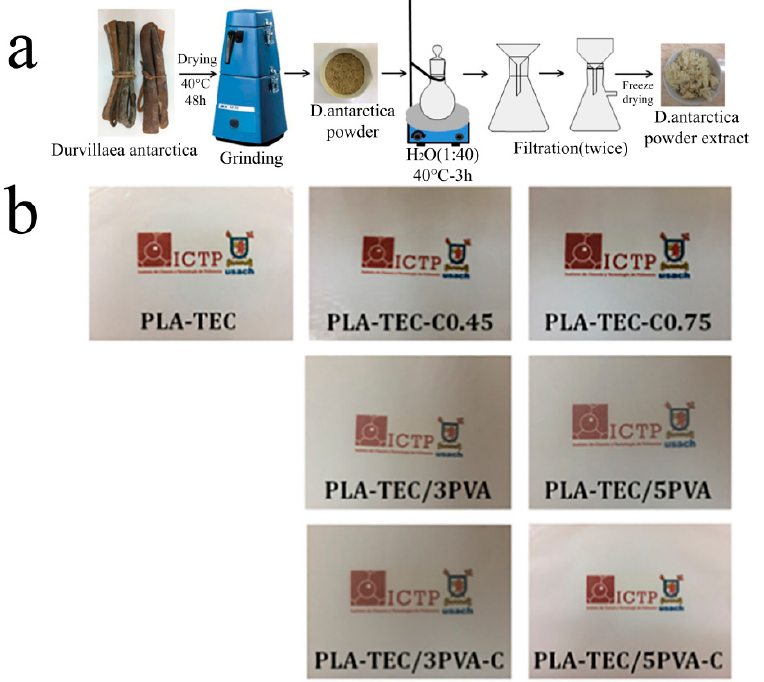
Figure 6. ( a ) Schematic representation of extraction procedure of D. Antarctica algae from natural algae to powder extract and ( b ) visual appearance of the obtained bionanocomposite films. (adapted from [75] ).